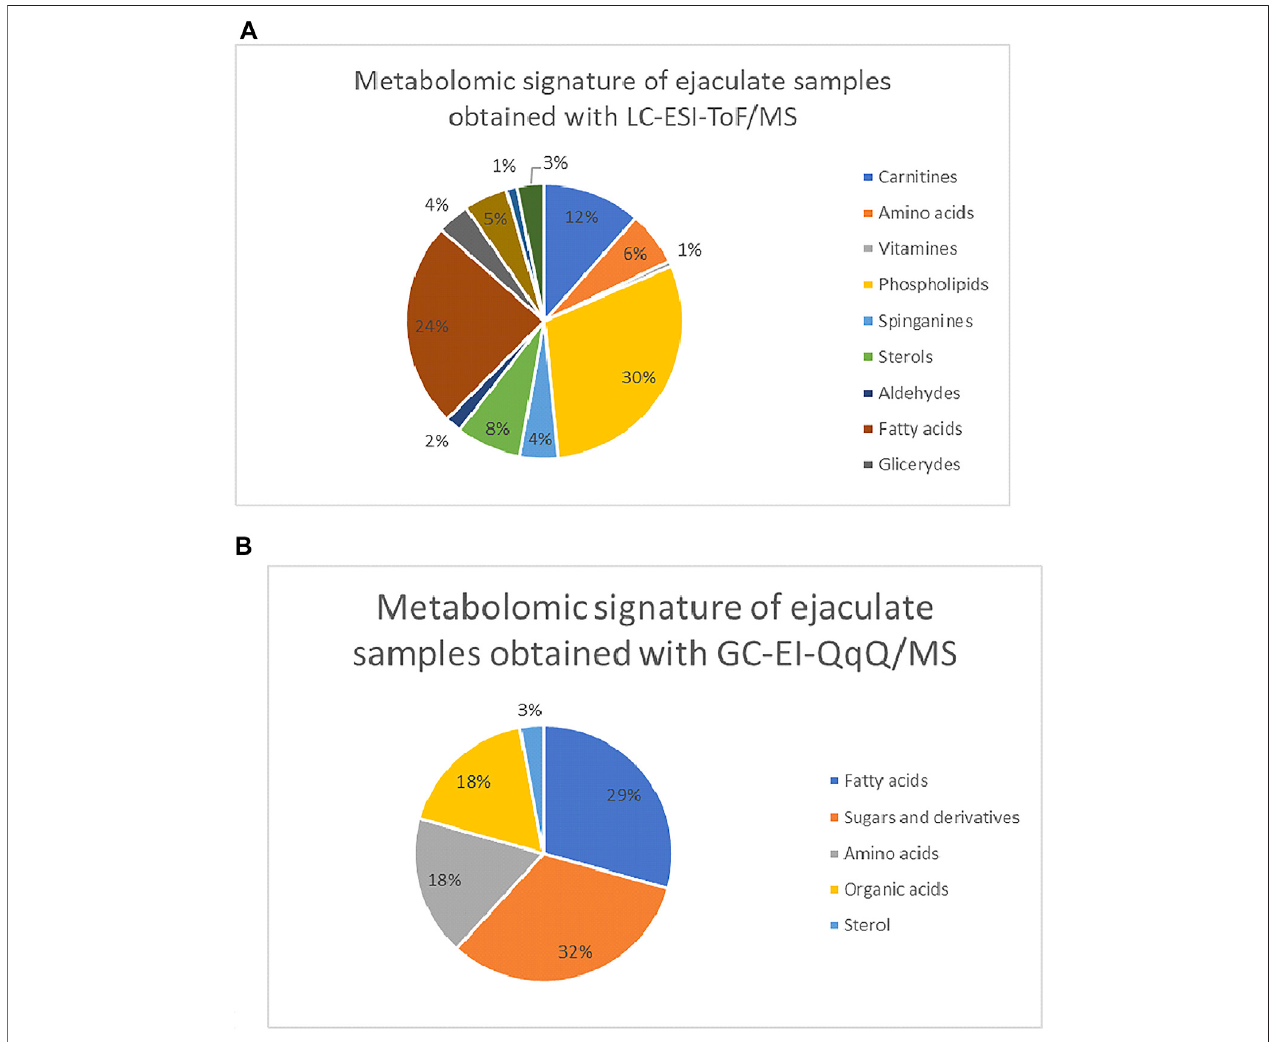
FIGURE 5 | Composition of metabolomics signature of ejaculate samples divided into the particular groups of compounds (A) for the LC-ESI-TOF/MS study and (B) GC-EI-QqQ/MS. 5.1 statistical comparisons.